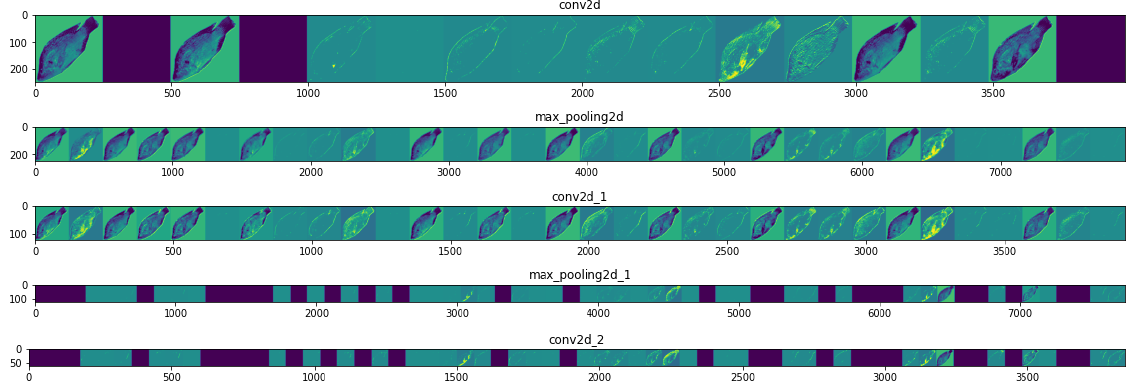
Figure 11. Feature maps visualization with landmarking labeling.